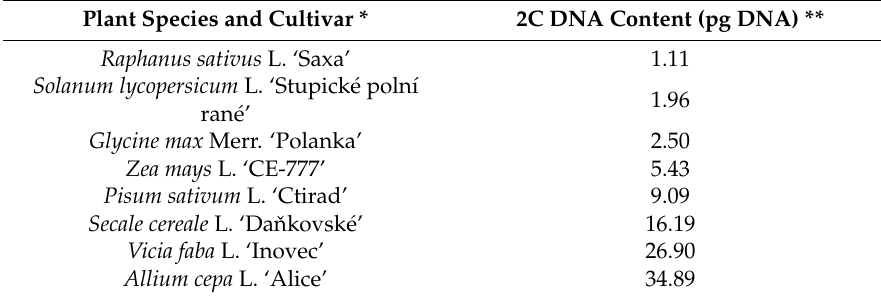
Table 1. Plant DNA reference standards calibrated for the estimation of nuclear DNA amounts in absolute units